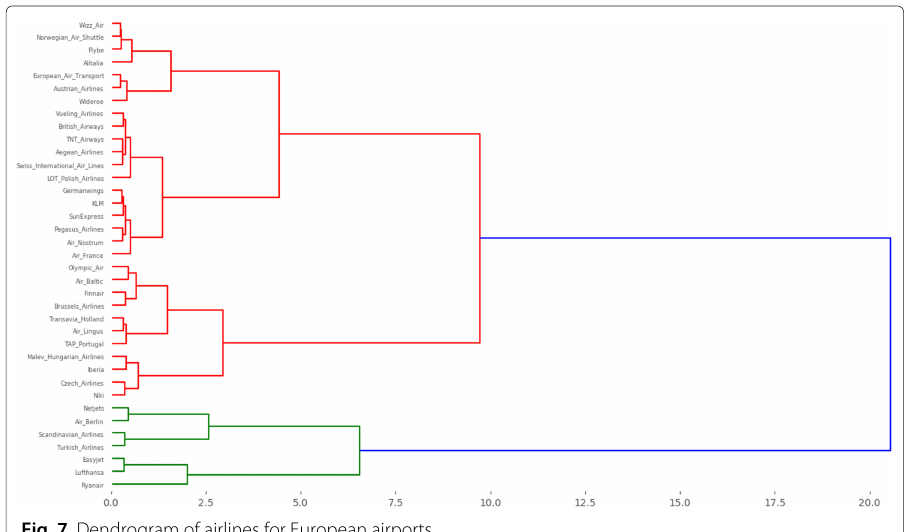
Fig. 7 Dendrogram of airlines for European airports